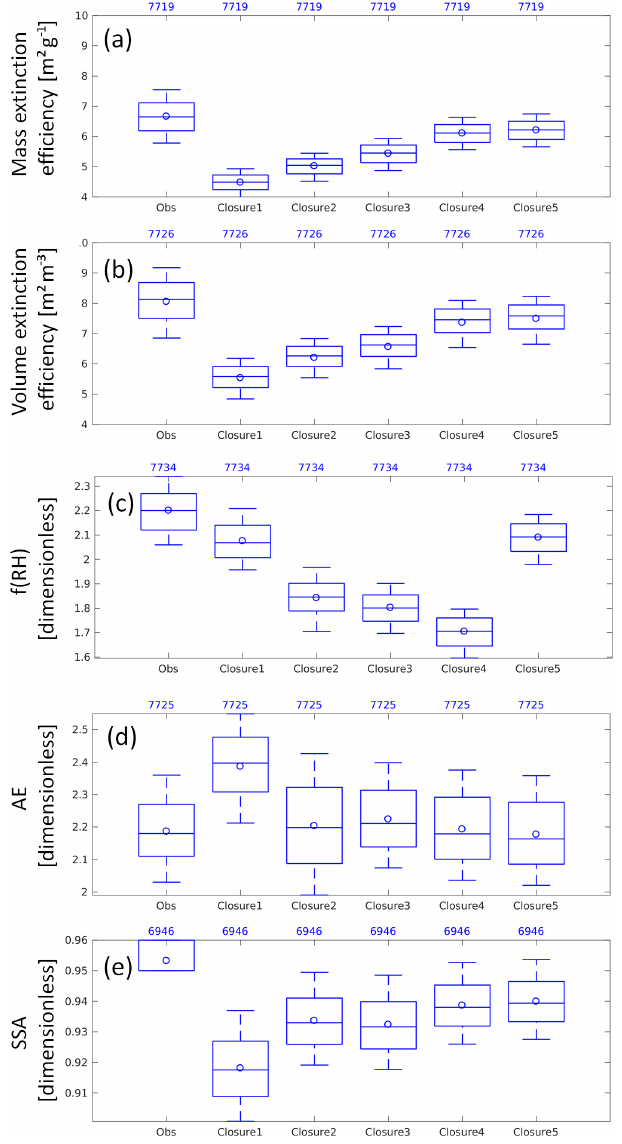
Figure 9. Box and whisker plots (as in Fig. 5) showing observa- tions and closure results driving the optical properties code with observations. Closure cases are described in Table 4. Results are shown for (a) the extinction-to-mass ratio (550nm; mass extinction efficiency), (b) extinction-to-volume ratio (volume extinction effi- ciency), (c) f (RH) measured at 550nm, (d) the 550–700 Ångström exponent, and (e) dry single-scattering albedo. The blue numbers on top of the plots represent the sample size used when computing